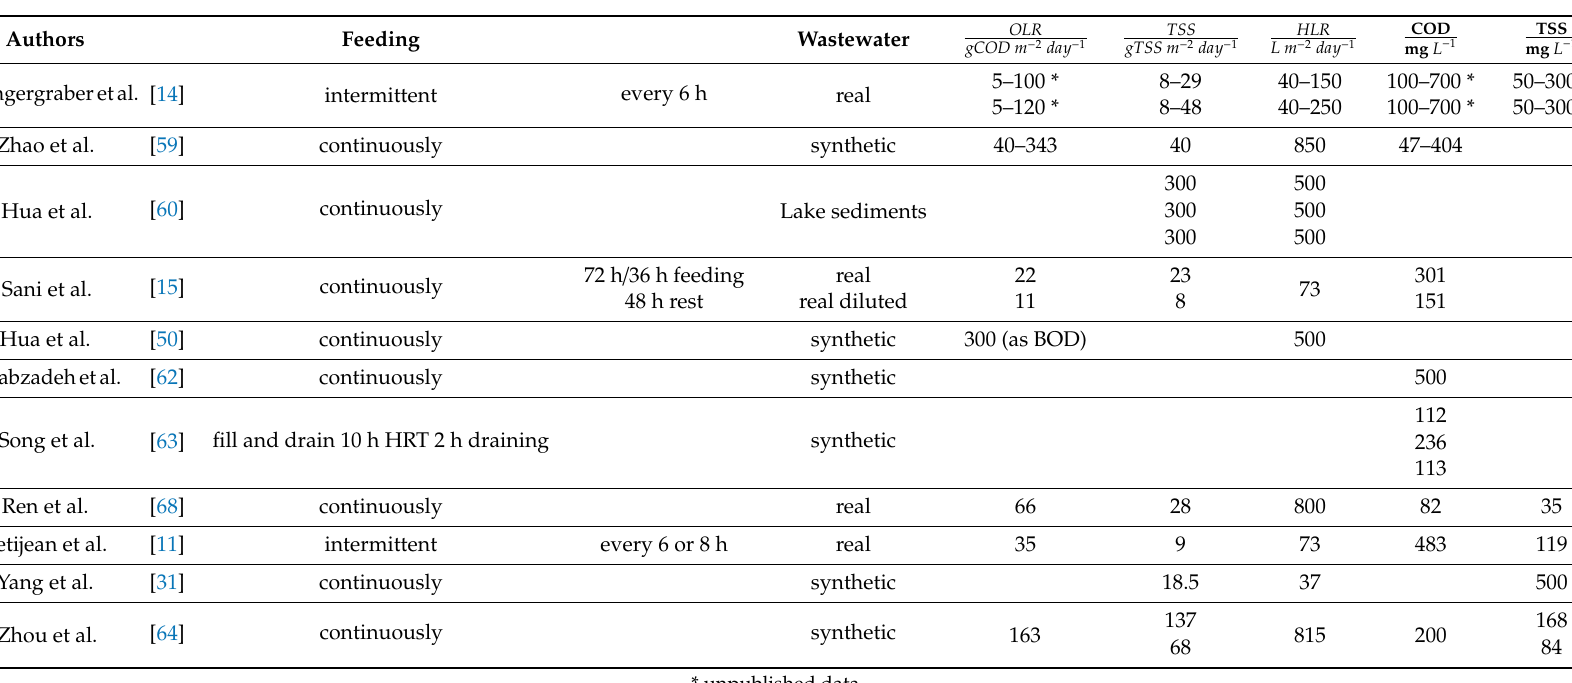
Table 4. Operational description of experimental